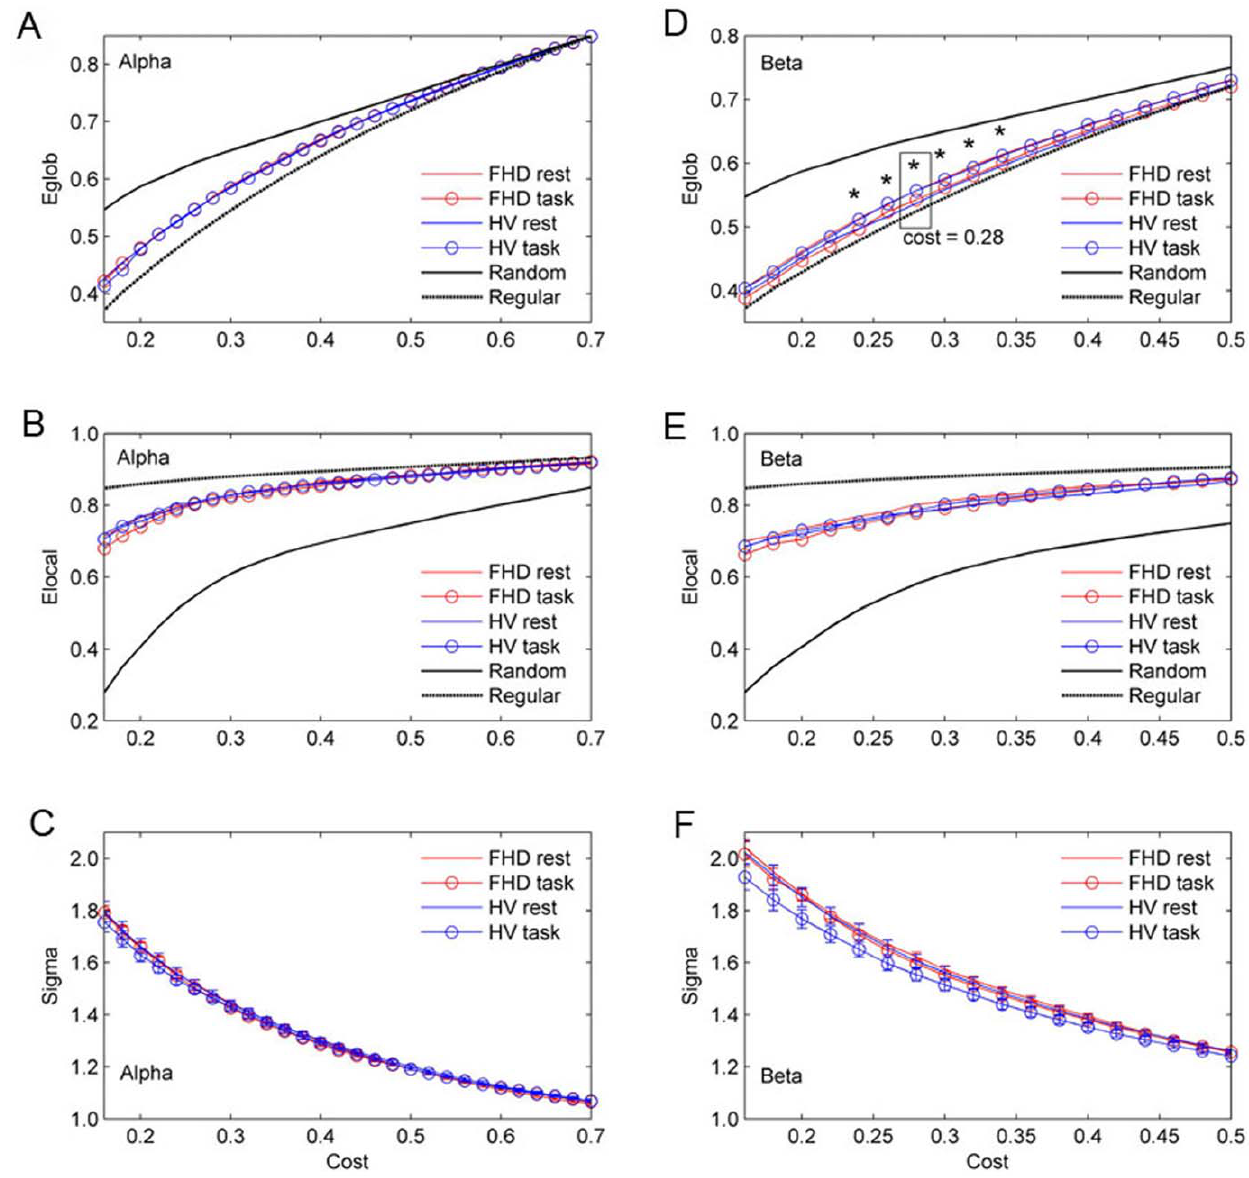
Figure 1. Eglob (a, d) and Elocal (b, e) as a function of cost for the random, regular, and brain networks. Small-world regime can be defined as the range of costs 0.16 , C , 0.7 in the alpha band network and 0.16 , C , 0.5 in the beta band network for which Eglob curve for both groups is greater than Eglob curve for the regular and less than random networks. Note that Eglob in the beta band network show interaction effect of group and condition in the range of 0.24 , C , 0.34. At a cost of 0.28, the most significant interaction of ANOVA is revealed (F 1, 56 =6.19, p =0.016). Small-worldness is achieved within this range, since sigma is . 1 in the range of costs 0.16 , C , 0.7 in the alpha network (c) and 0.16 , C , 0.5 in the beta band network